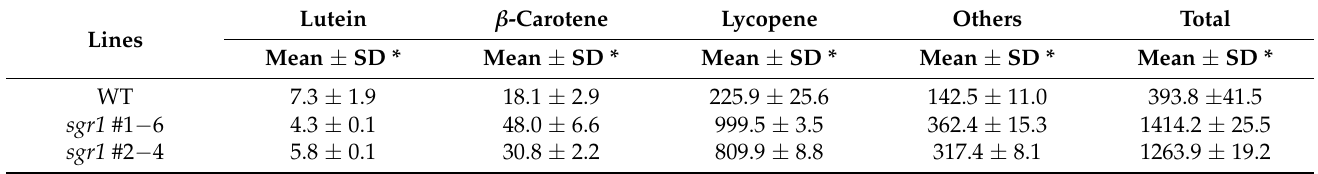
Table 3. Determination of carotenoid levels in sgr1 #1 − 6, sgr1 #2 − 4, and wild-type (WT) plant fruits at